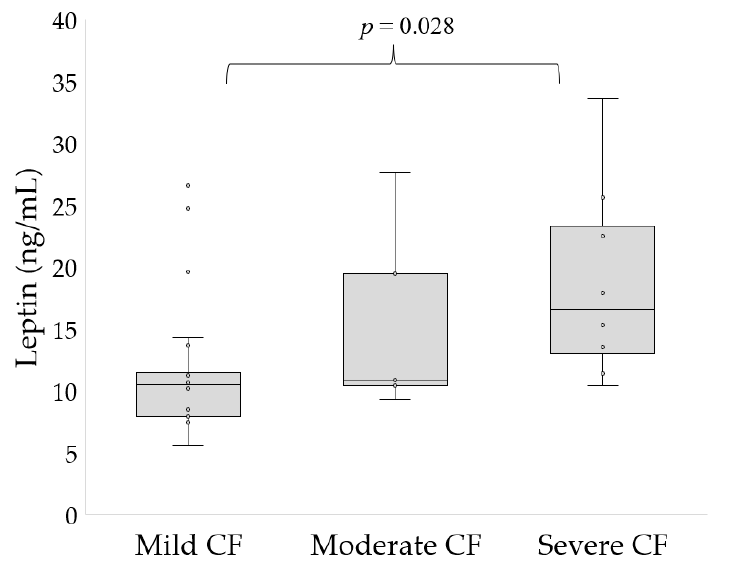
Figure 1. Levels of leptin depending on the disease severity.